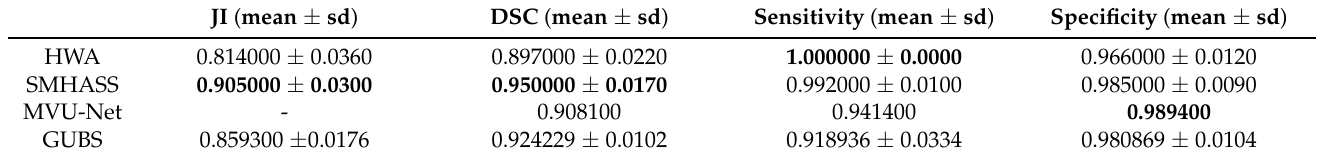
Table 3. Performance analysis of GUBS compared to HWA, SMHASS [17] and multi-view U-Net (MVU-Net) [19] methods based on the IBSR data set by presenting the average in each measure of